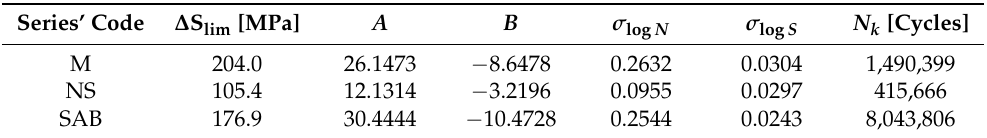
Table 2. Fatigue limit range and S-N curves’ parameters related to machined, net-shape and sand- blasted